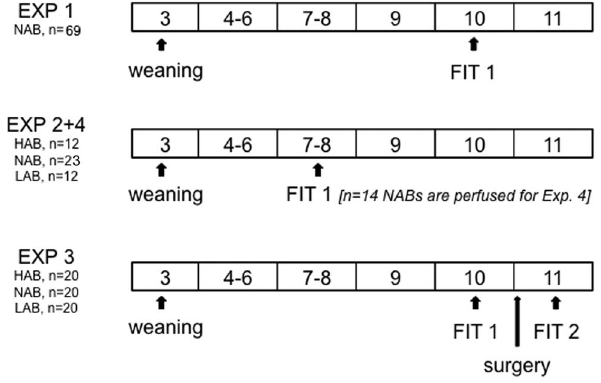
Figure 1. Timeline of experiments.